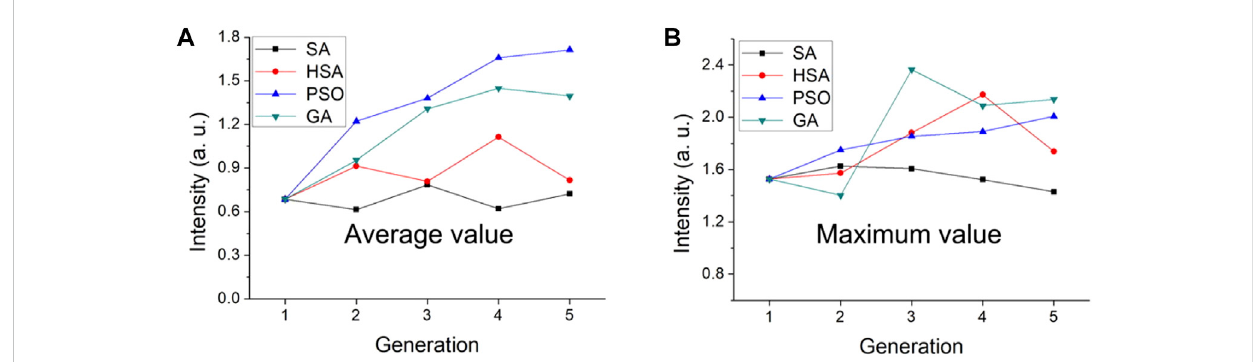
FIGURE 3 ComparisonofSA,HSA,PSO,andGAalgorithmstothe fi nalaverageandmaximumluminescenceintensity.Varianceof (A) allconcentrationsand (B) the Ce/Tb concentrations in different generations. [Reprinted with permission from Ref. (Lv et al., 2019) Copyright 2019: American Chemical